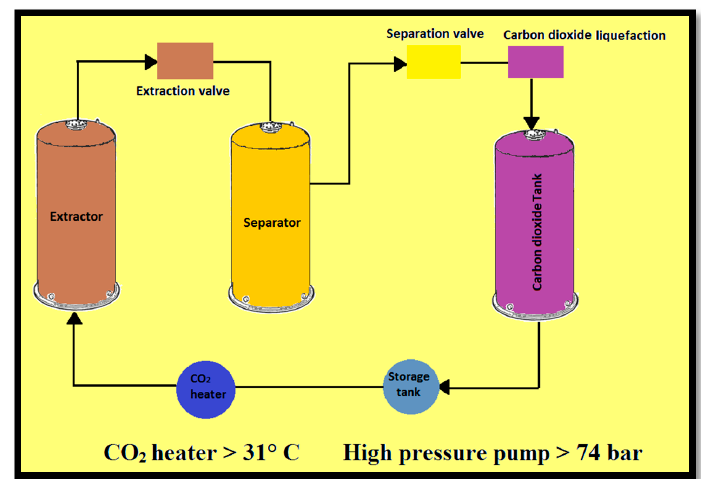
Figure 4. Supercritical fluid extraction using CO 2.